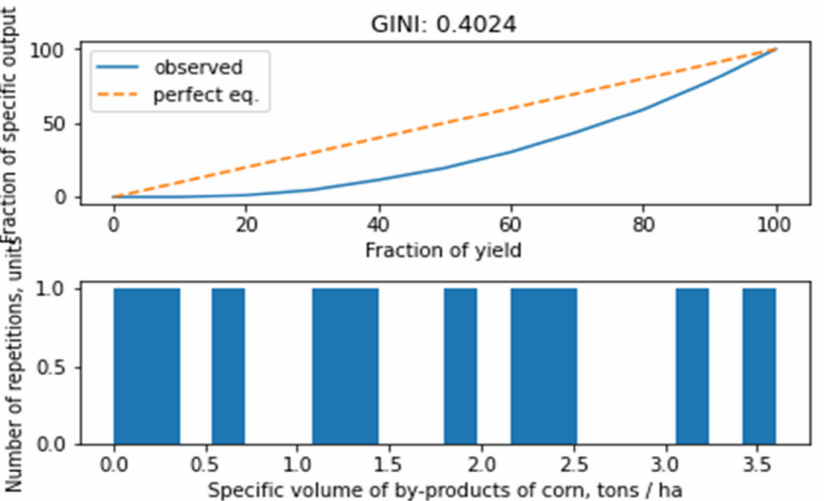
Figure 5. Lorentz curve, built on indicator I, for the conditions of Khmelnytskyi region